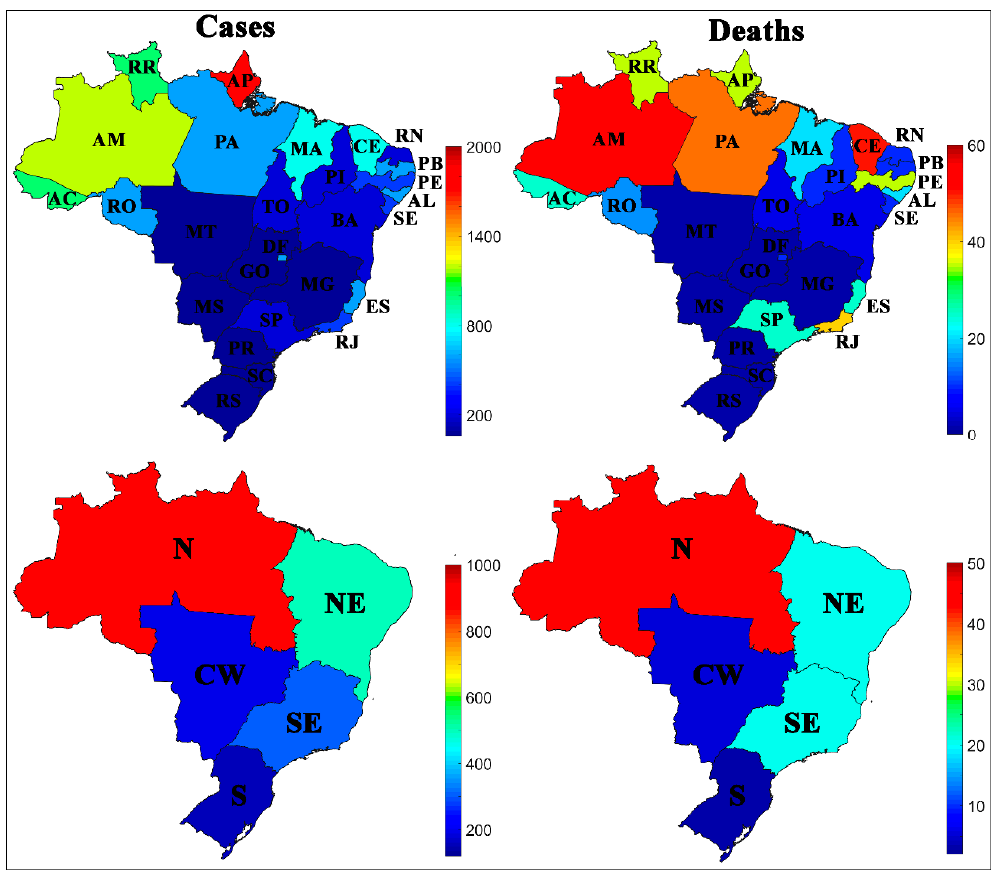
Figure 1. Geographical distribution of cases and deaths by COVID-19 in Brazilian states (above) and regions (below) per 100,000